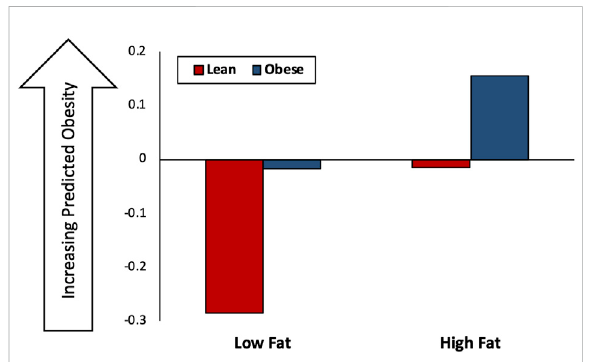
FIGURE 2 Predictions for change in microbiome in response to host diet. Y-axis is average PCC between predicted and observed mouse gut microbiome community structures for randomly generated subsets of training and validation data. On x-axis is the two modeling approaches considered: “ Network-based ” and “ Non-network Based ” models. Average results for Training and Test data subsets are shown. Error bars are +/ − one standard